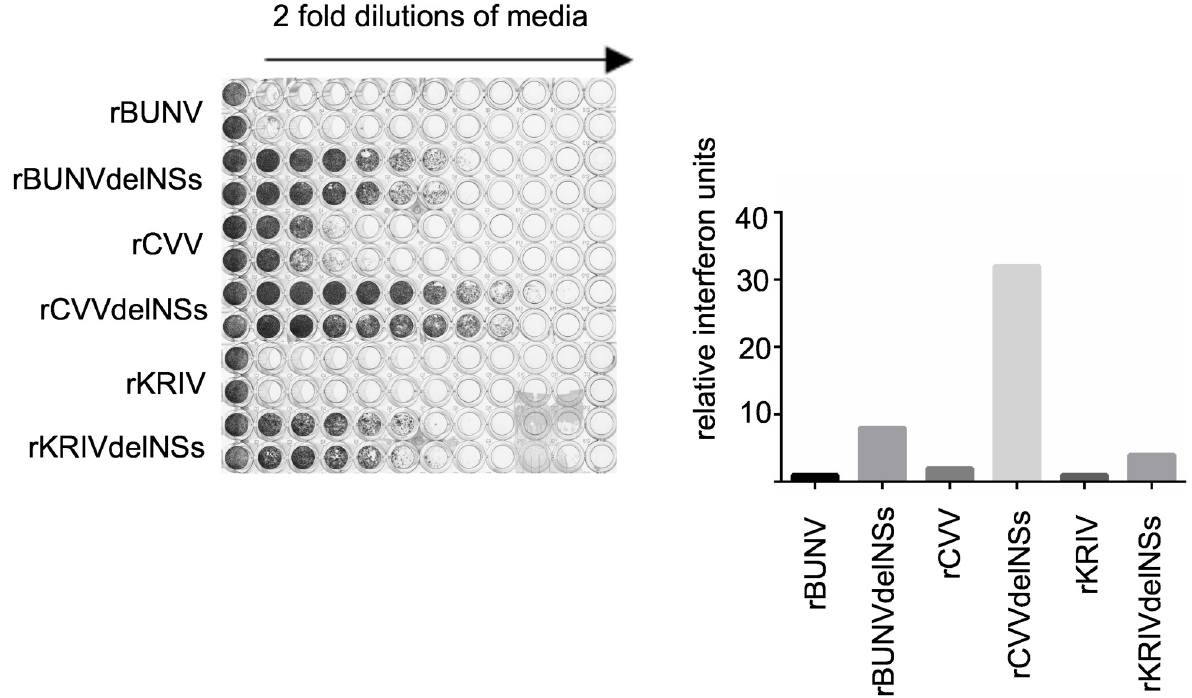
Fig 5. Type I IFN protection assay for orthobunyaviruses. A549 cells were infected with rBUNV, rCVV, rKRIV or rCVVdelNSs, rBUNVdelNSs (clone rBUNVdelNSs2) or rKRIVdelNSs at a MOI of 1 and incubated at 37 ˚C for 48 hrs. Twofold dilutions of the clarified and UV-treated supernatant were used to treat fresh A549 NPro cells in a 96-well plate for 24 hrs. The cells were then infected with EMCV and the development of CPE was monitored at 96 hrs post-infection by staining with crystal violet. The production of IFN was calculated according to the highest dilution of supernatant giving protection against EMCV infection and is expressed as relative IFN units. The experiment was conducted three times and gave identical